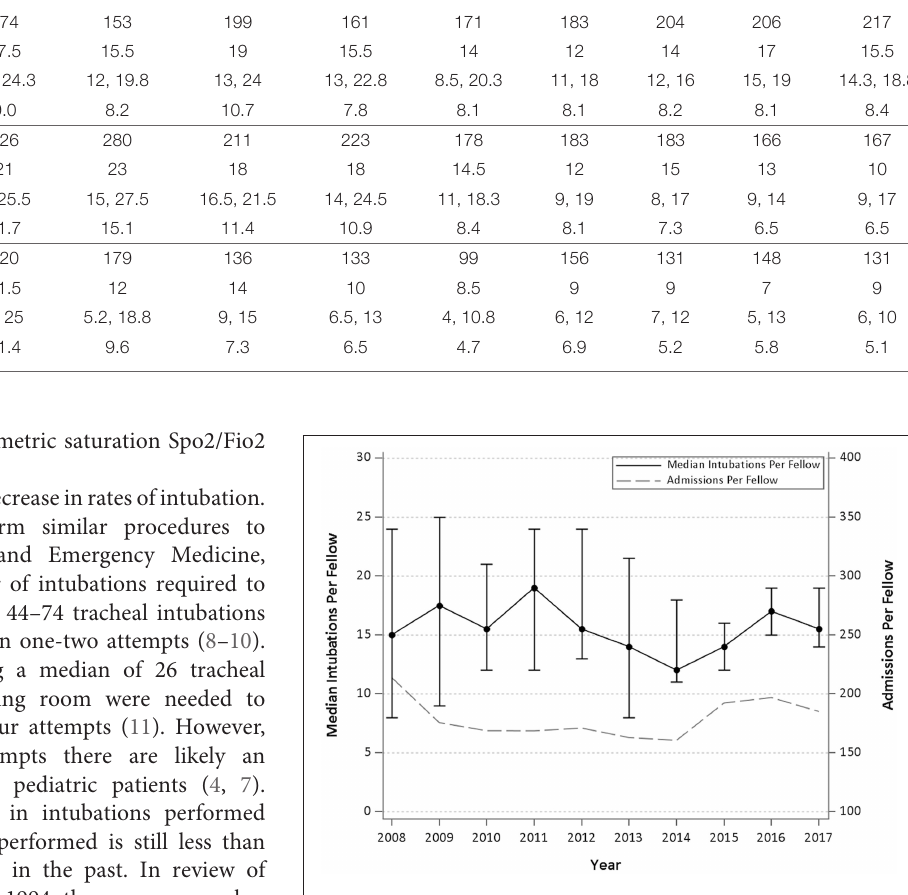
FIGURE 1 | Median and interquartile range of intubations per Fellow per year and admissions per Fellow year over 10